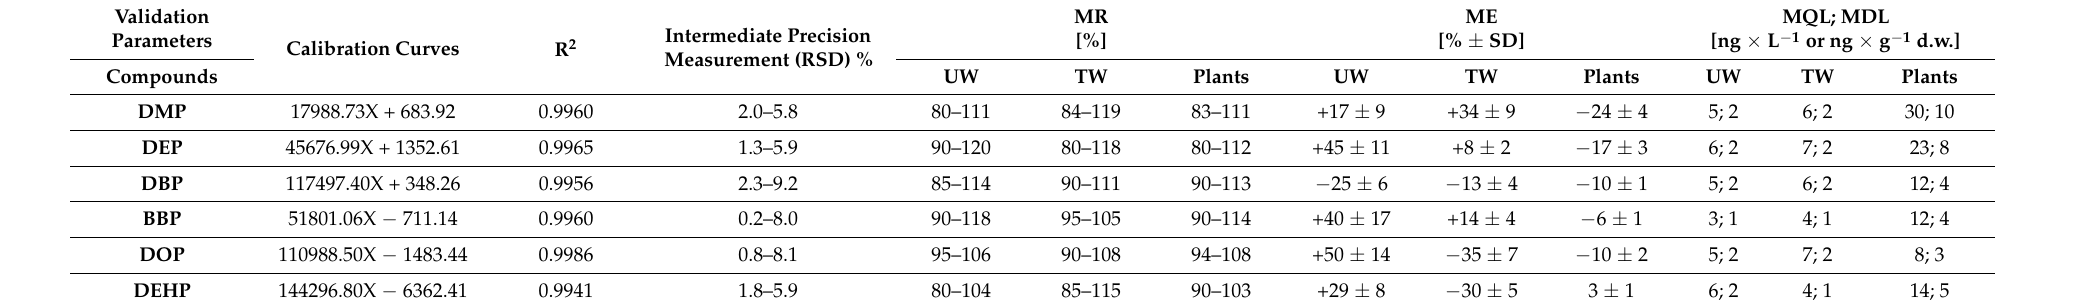
Table 3. Selected validation parameters of the developed methods for determining target compounds in wastewater and plant samples from an MWWTP (analytical range from MQL to 2500 ng × g − 1 for plant samples, and from MQL to 1000 ng × L − 1 for wastewater samples, n = 3). Abbreviations: MR—mean recovery; ME—matrix effect; MQL—method quantification limit; MDL—method detection limit; UW—untreated wastewater; TW—treated